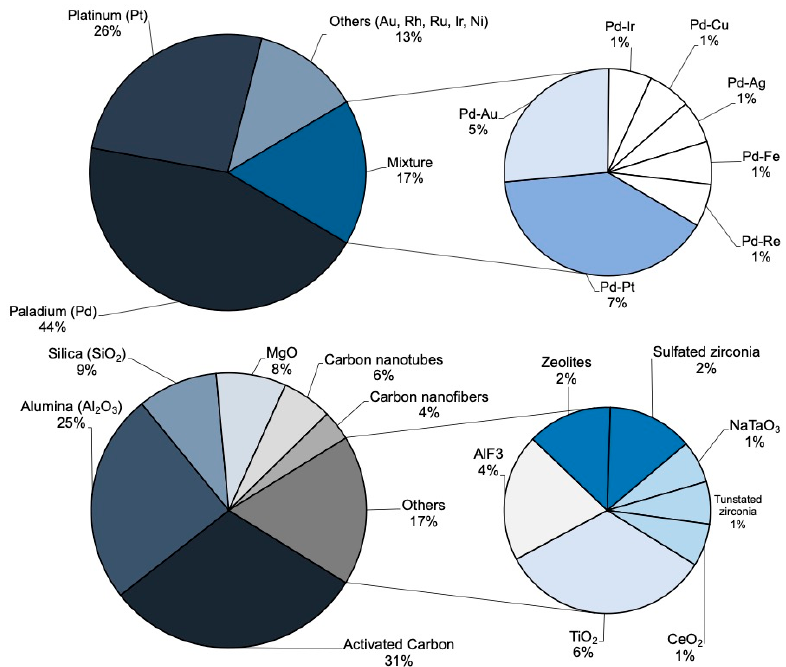
Figure 2. Active phase metals and support materials used in HDC of chloromethanes in the last 25 years.